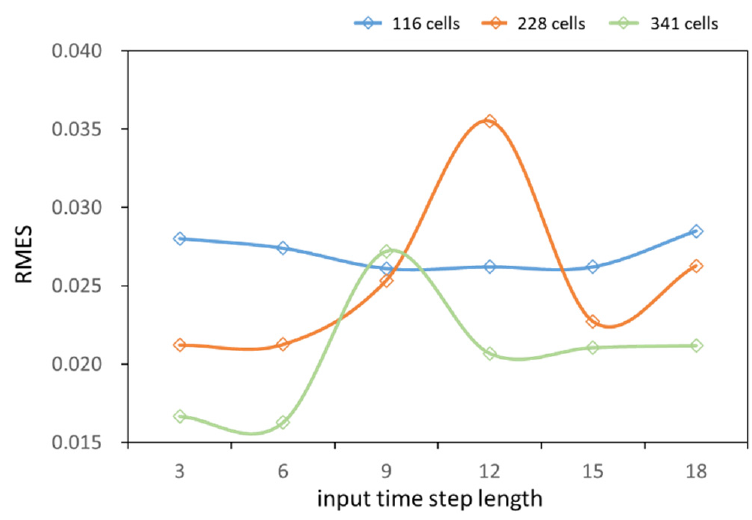
Figure 13. Predictive accuracy, in terms of the root mean square error (RMSE) versus the input time step length.